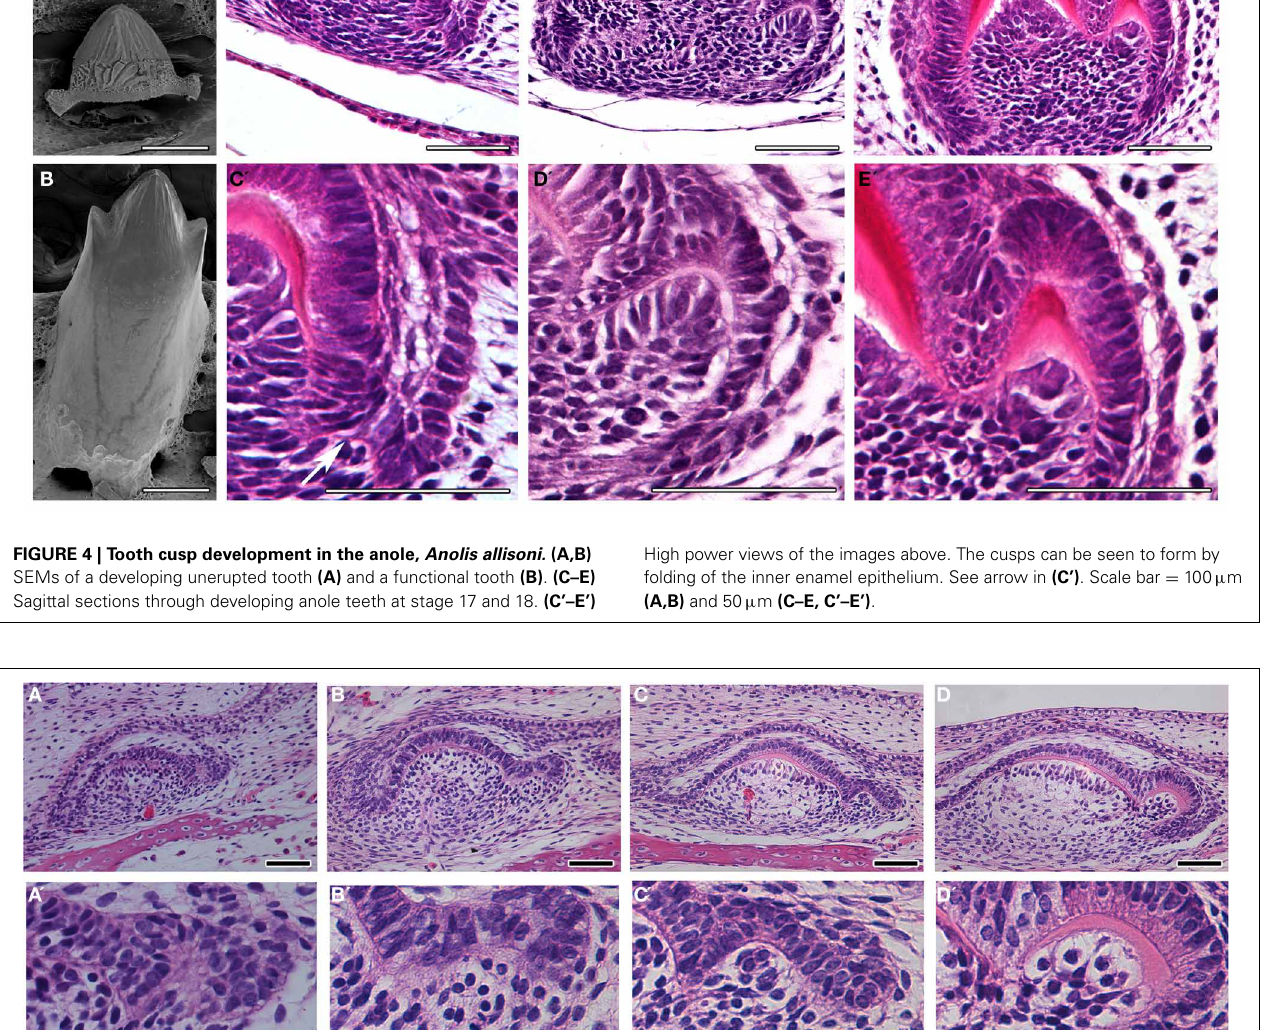
FIGURE 5 | Tooth cusp development in the chameleon. (A,A’) Tooth at the cap stage with no deposition of hard tissue. A developing accessory cusp is visible on the RHS. (B,B’) The inner enamel epithelium on the RHS starts to fold, associated with a ball of underlying mesenchymal